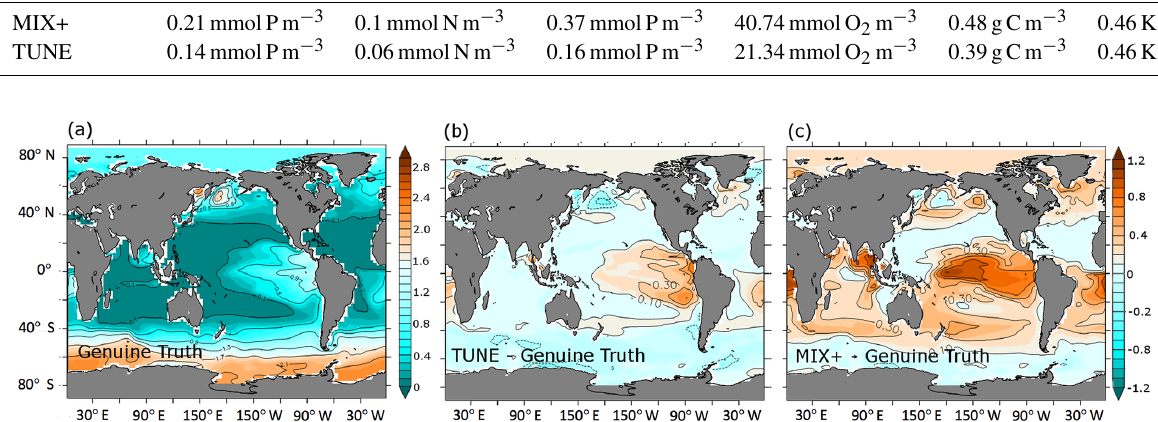
Figure 4. Simulated surface phosphate concentrations in millimoles of phosphate per cubic meter (mmolPm − 3 ) for the historical simulations (see Sect. 2.2.2). Panel (a) refers to results from the model configuration Genuine Truth. Panels (b) and (c) show the difference between the results from the model configurations TUNE and MIX+ and the Genuine Truth, respectively. MIX+ and TUNE feature increased vertical background diffusivity relative to the Genuine Truth. In addition, TUNE features retuned biogeochemical model parameters (see Table